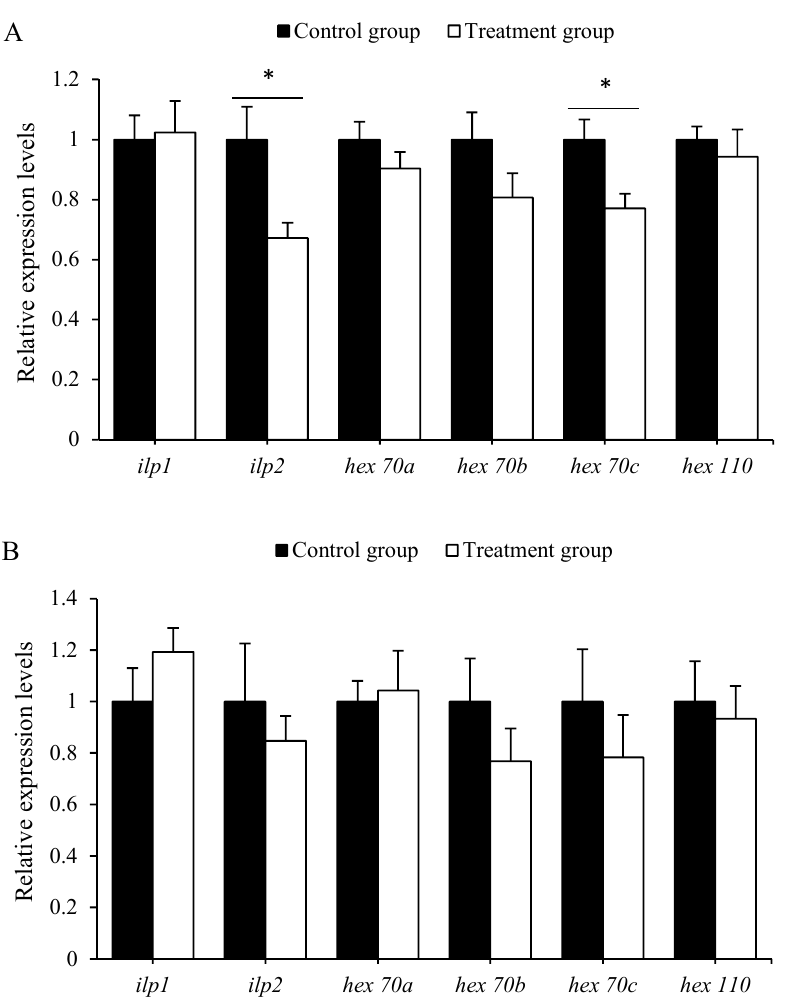
Figure 3. Antibiotics treatment effect on the expression of six nutrient metabolism-related genes in 5-( A ) and 7-day-old ( B ) A. mellifera larvae. The asterisk above the bars indicates a significant difference in gene expression level between the treatment and corresponding control (* for p < 0.05).